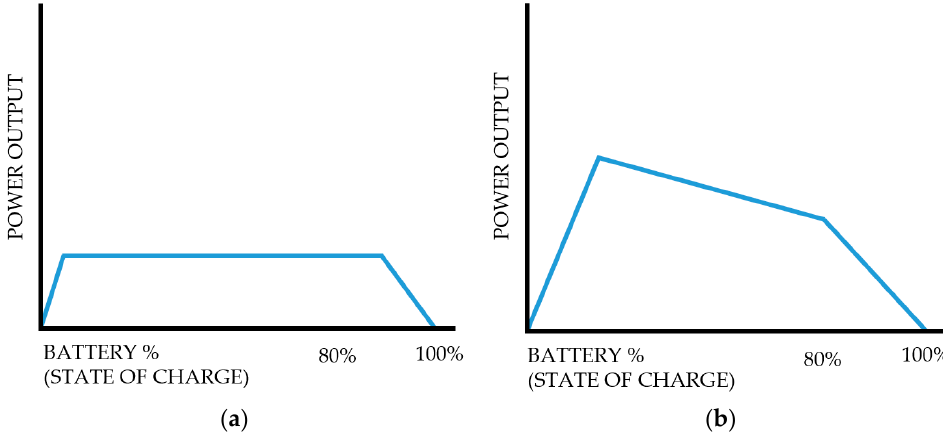
Figure 1. ( a ) AC charging curves; ( b ) DC charging curves.